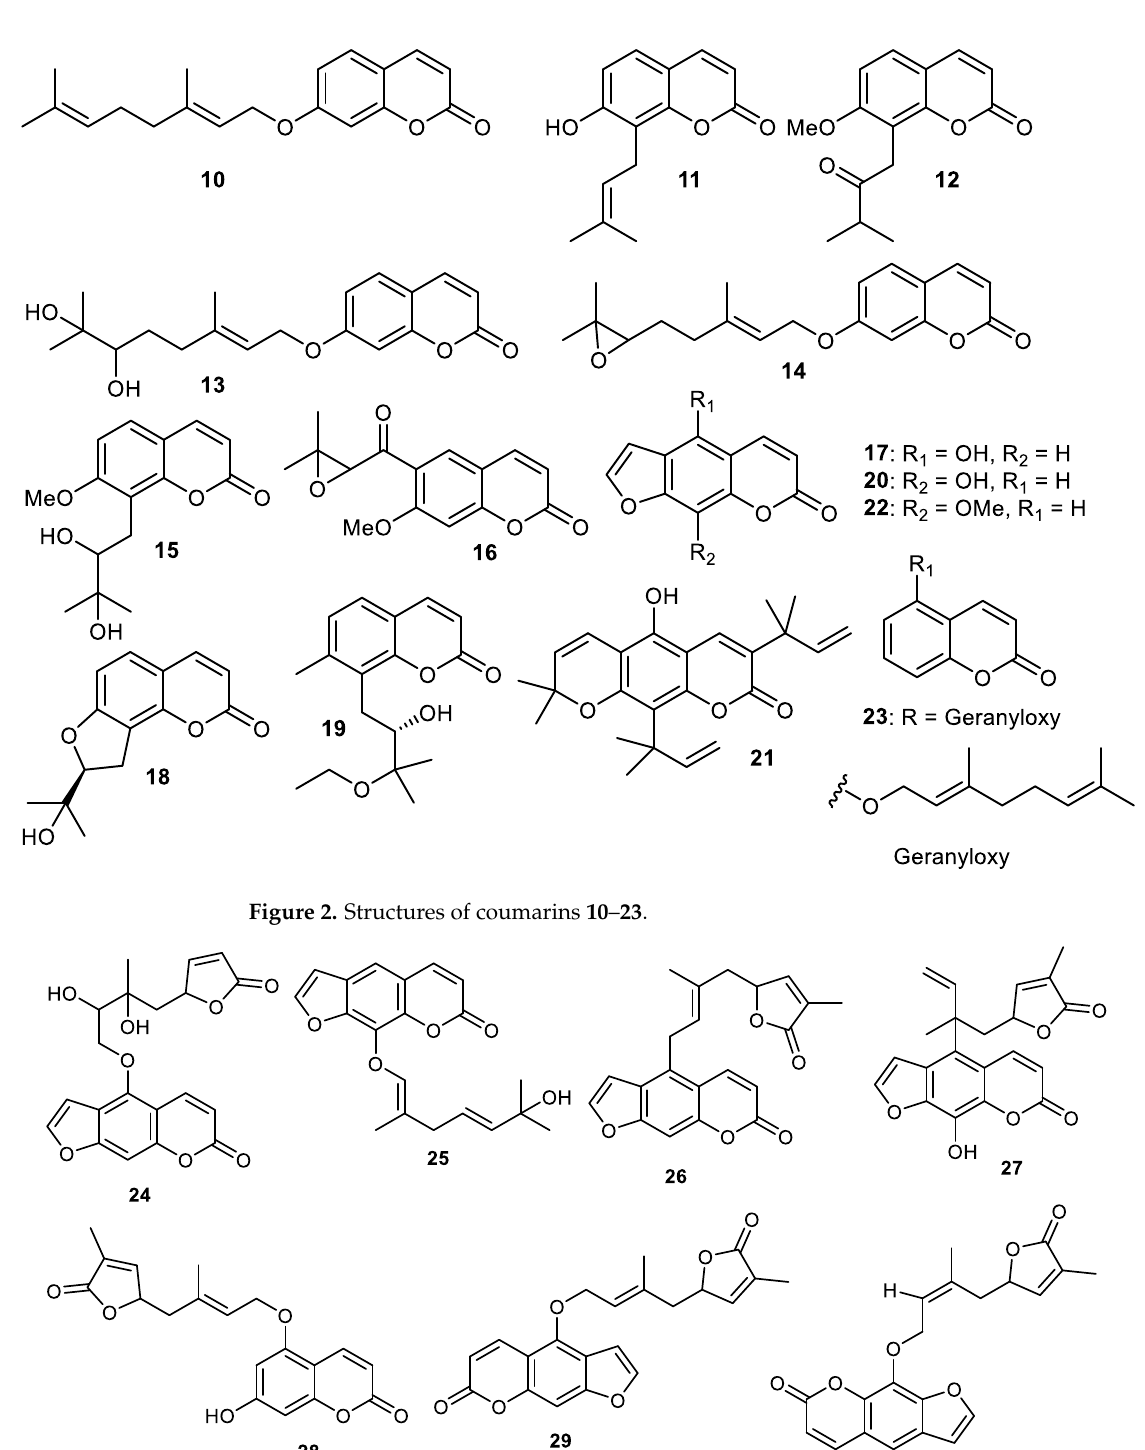
Figure 3. Structures of coumarins 24 – 30 .